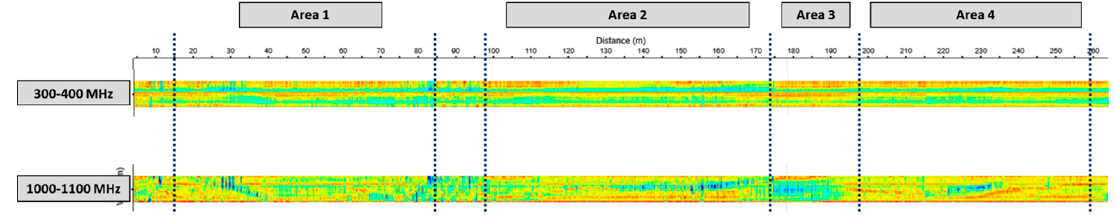
Figure 8. Low frequency effects.